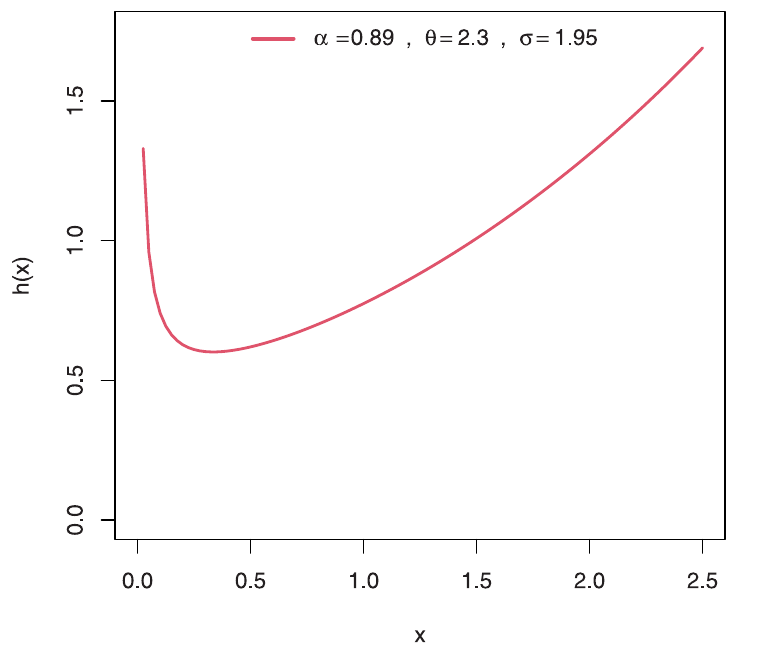
Fig 5. Plots of EGuNH hazard rate for a variety of parameter combinations.